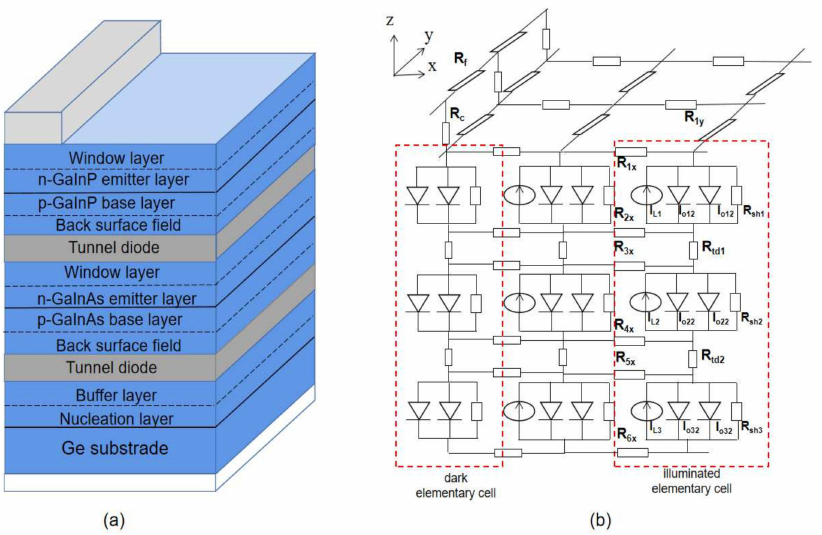
Figure 2. ( a ) GaInP/GaInAs/Ge triple-junction solar cell; ( b ) Double diode circuit network